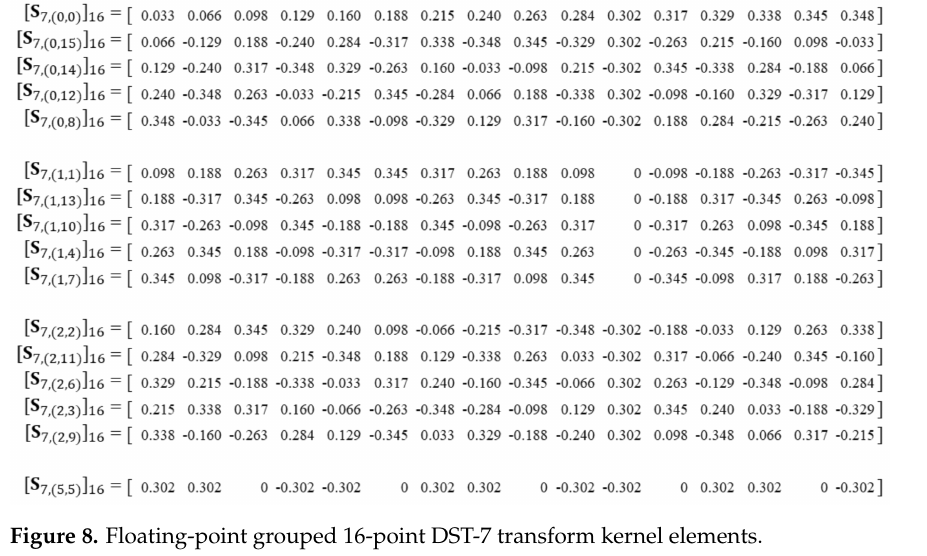
Figure 8. Floating-point grouped 16-point DST-7 transform kernel elements.